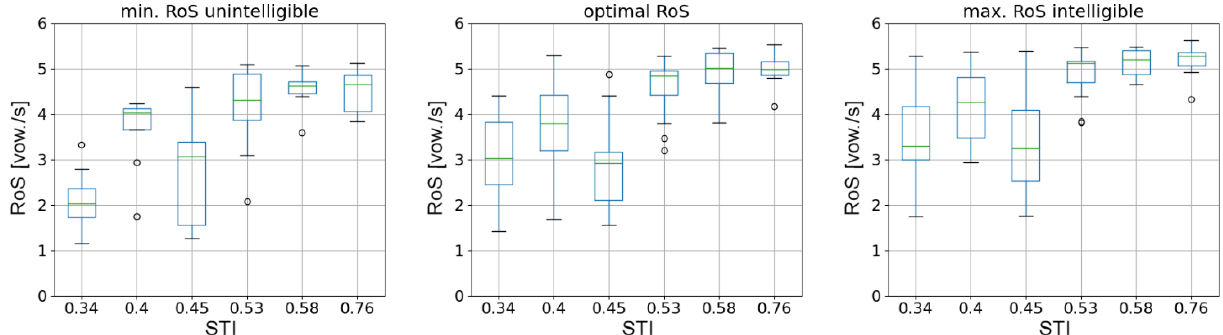
Figure 4. Boxplots depicting the RoS value as a function of STI associated with each of the six impulse responses considered in the study. The leftmost figure depicts RoS values associated with the lowest utterance tempo for which speech was already unintelligible, optimal RoS values for each STI are shown in the middle figure, the rightmost figure shows the maximum RoS value for which speech was intelligible for each STI value.